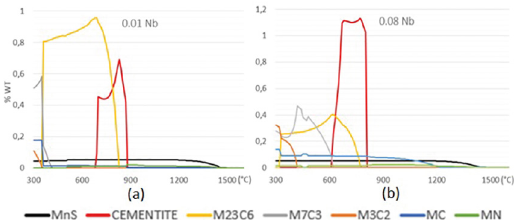
Figure 5. Thermodynamic simulation performed on 0.01 (a) and 0.08 (b) niobium